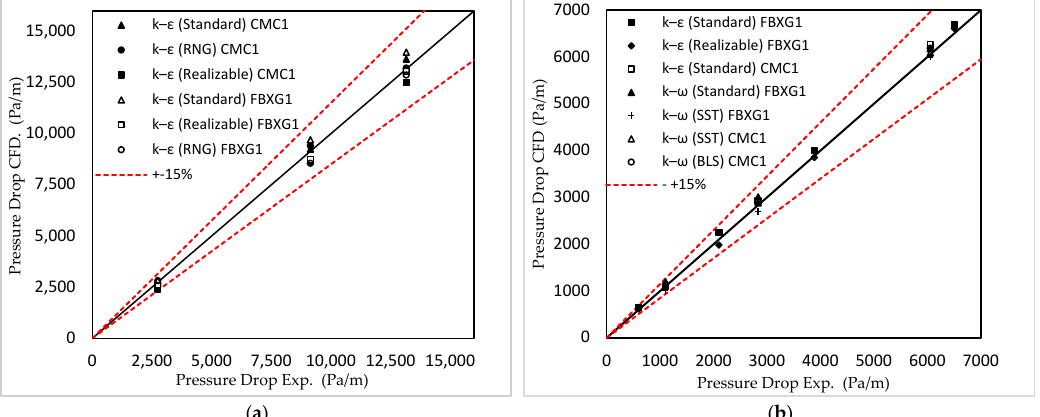
Figure 12. Comparison of frictional pressure drop obtained from CFD model vs. experimental data. ( a ) FBXG1 and CMC1 power-law fluids pipe diameter 19.1 mm. ( b ) FBXG1 and CMC1 power-law fluids pipe diameter 76.2 mm.